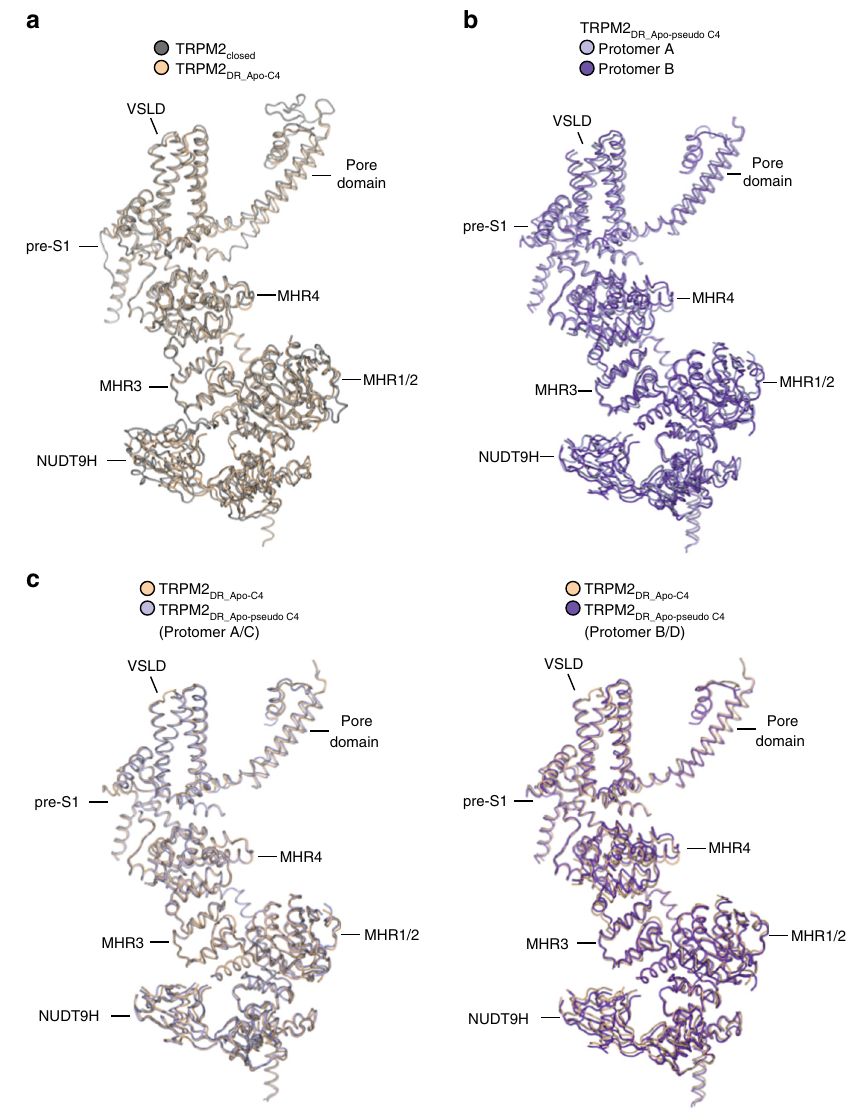
Fig. 2 Comparison of TRPM2 DR structures in the ligand-free condition. a Alignment (cartoon representation) of a protomer from the TRPM2 DR_Apo-C4 structure (wheat) and from the TRPM2 closed structure (silver, PDB 6DRK). b Alignment of protomers A (light purple) and B (purple) of the TRPM2 DR_Apo-pseudo C4 structure. c Alignment of a protomer from the TRPM2 DR_Apo-C4 structure (wheat) with protomers A/C (left, light purple) and B/D (right, purple) from the TRPM2 DR_Apo-pseudo C4 structure,